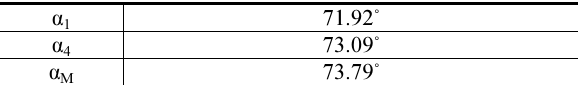
Fig. 13. Comparison of tangential angles for given models, where: tangential I – indicates the model without a matrix film; tangential IV indicate the model with the matrix film of 50 µm Table 3. Stiffness for given models